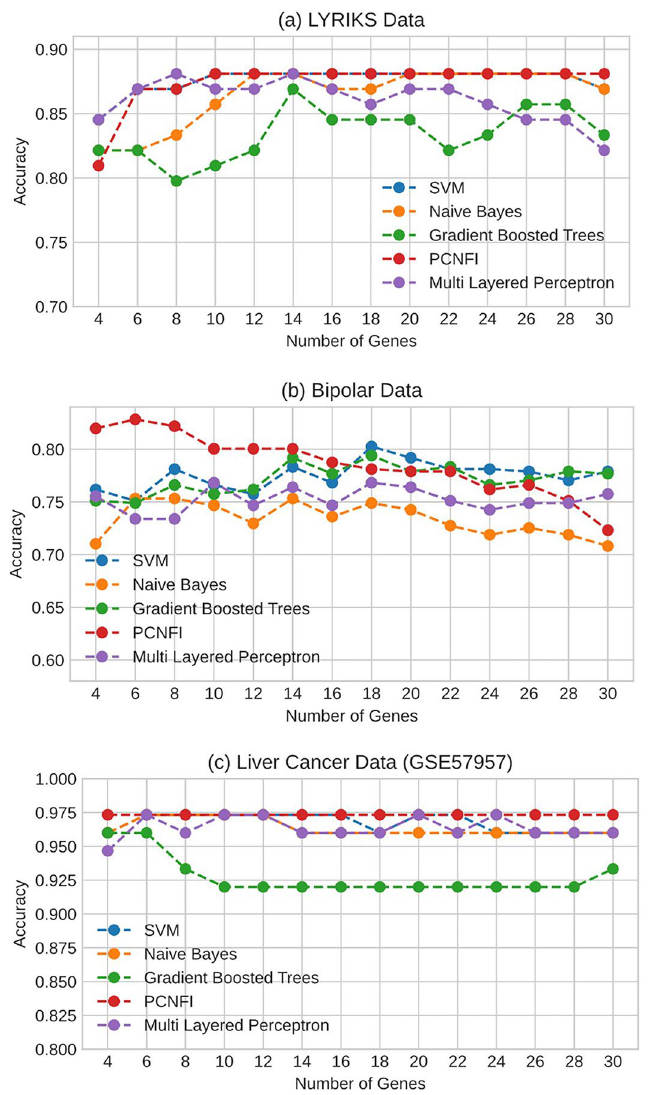
Figure 3. Classification accuracy of PCNFI compared with other methods. ( a ) Classification accuracy on the LYRIKS dataset into UHR vs control groups ( b ) the Bipolar dataset into bipolar versus control groups ( c ) and Liver cancer dataset with an increasing number of features (genes) selected by SNR for every personalised model. Features can be different for each model, but many are presumed to be similar across individual